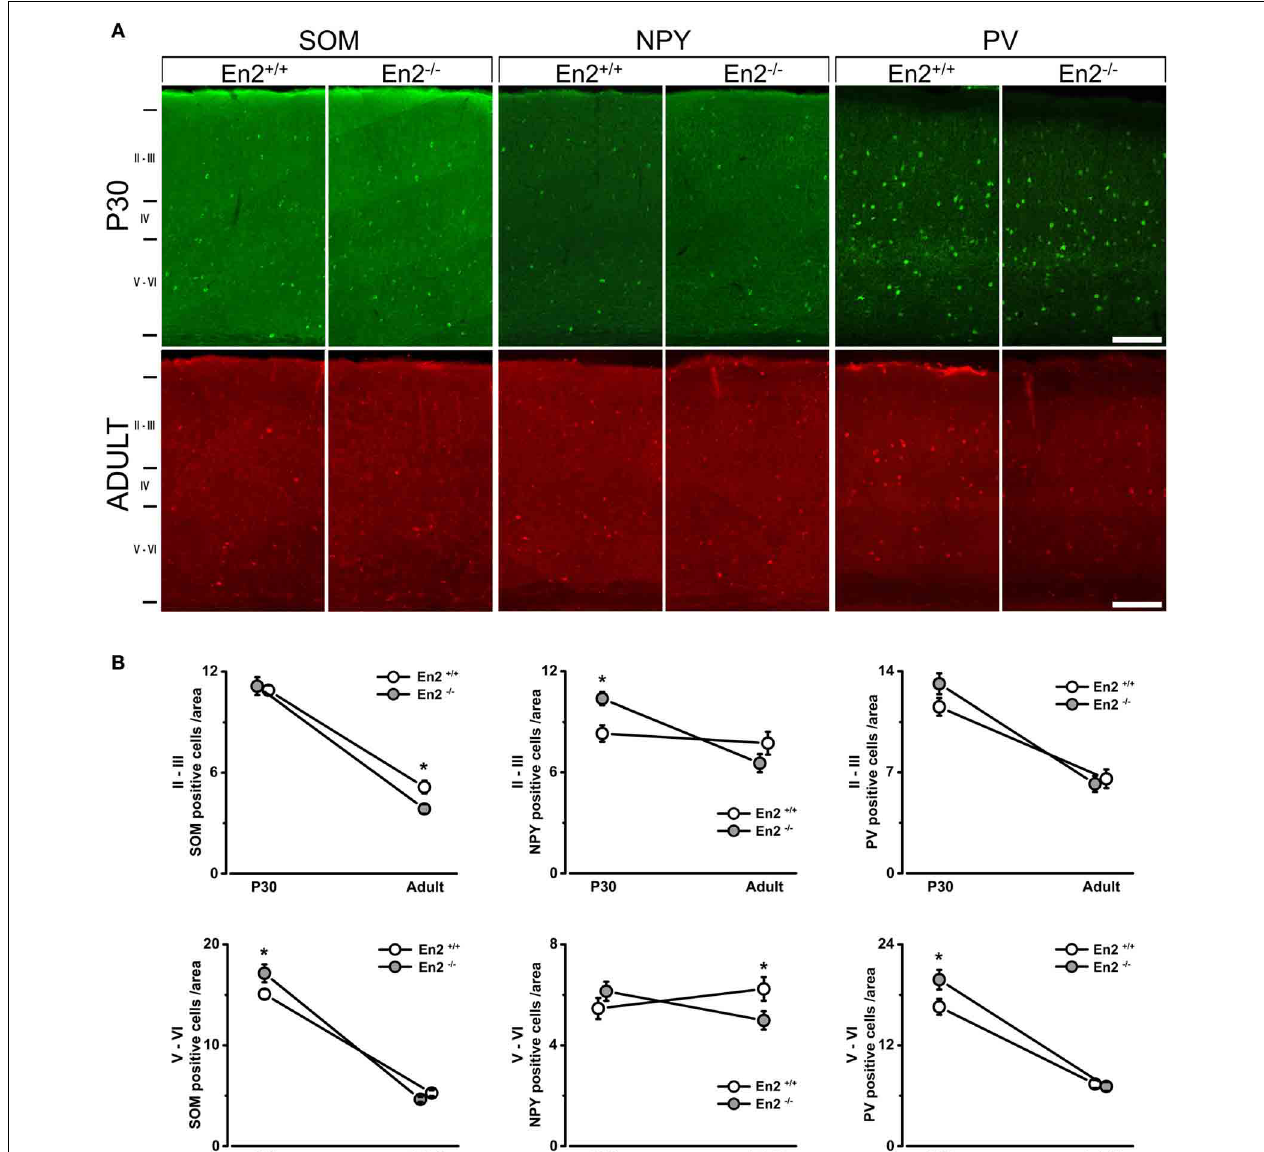
FIGURE 3 | Increased density of SOM + , NPY + , and PV + cells in the primary visual cortex of juvenile En2 − / − mice. (A) Representative SOM, NPY, and PV immunostainings taken at the level of the primary visual cortex in P30 and adult En2 + / + (white) and En2 − / − (gray) mice. (B) Quantification of immunohistochemistry experiments. Cell densities in layers II–III and V–VI are